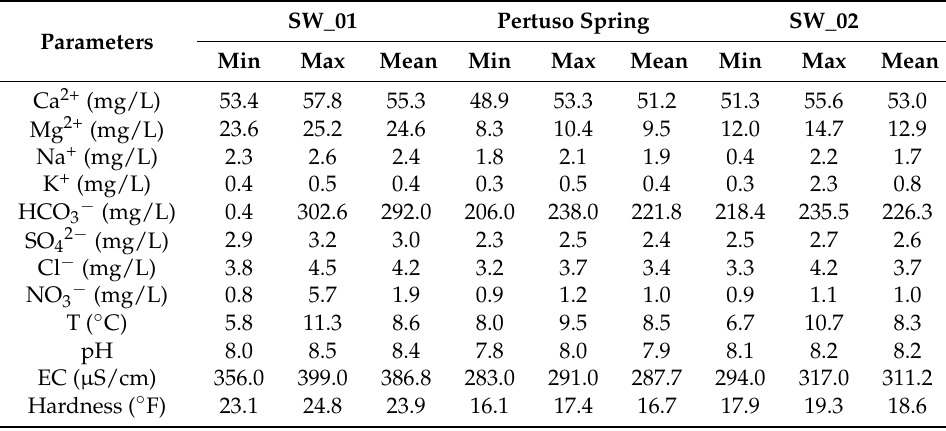
Table 1. Summary statistics for in situ measurements of physicalochemical parameters and chemical concentrations of constituents of water